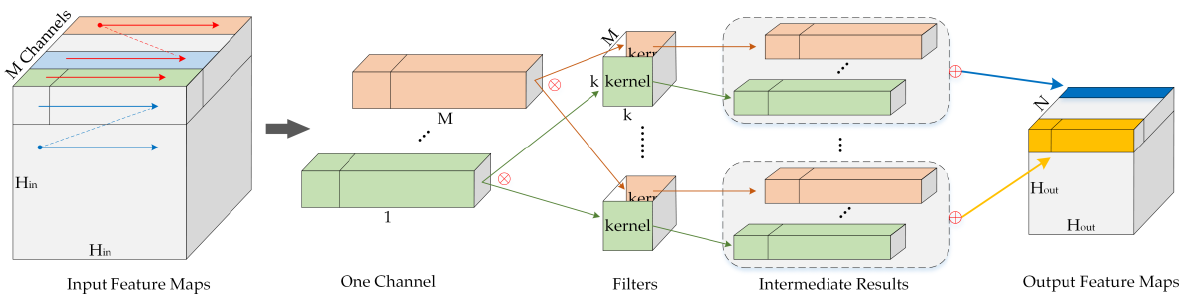
Figure 6. The computing pattern of the standard convolutions.